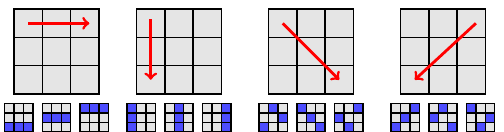
( ∞ , 0, 1, 2, respectively) along which Bob may be asked to shoot in the d = 3 Torpedo Game. For each direction, Bob has three possibilities, depicted by the blue lines. In the affine plane of order 3, each of these groups of three blue cells forms a